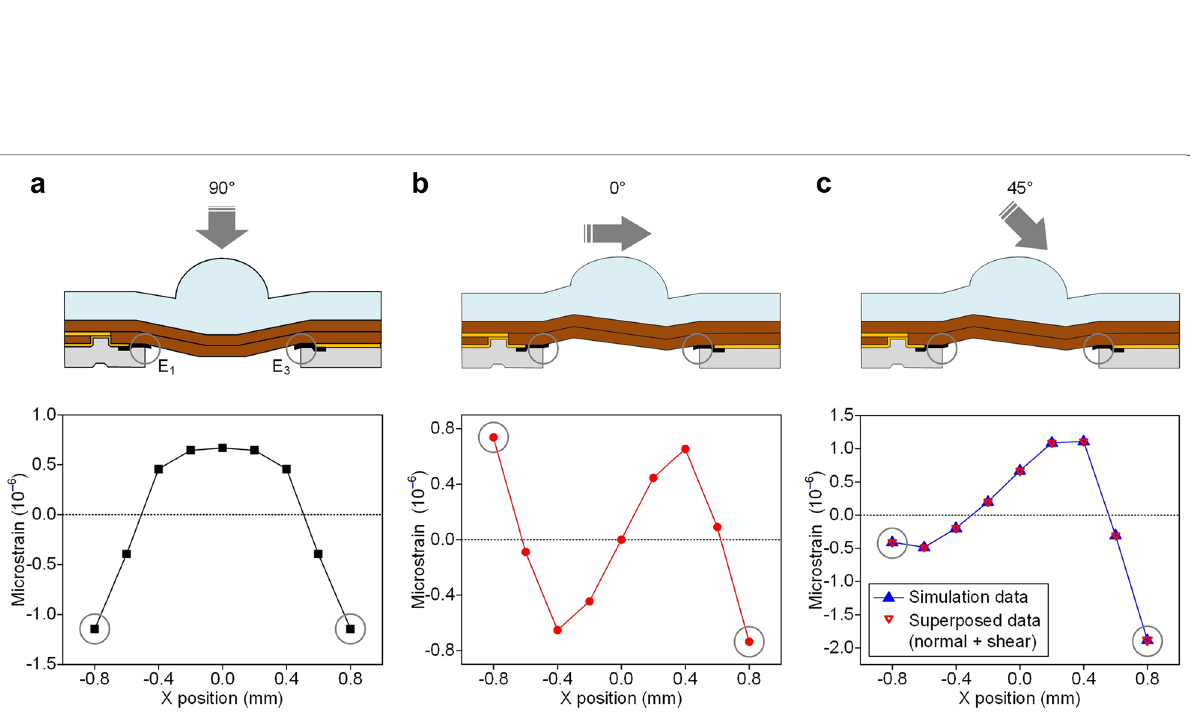
Fig. 5 FEA results for strain generated along the PI surface in response to the input force at a 90°, b 0°, and c 45°. The strain value depends on the direction of the applied